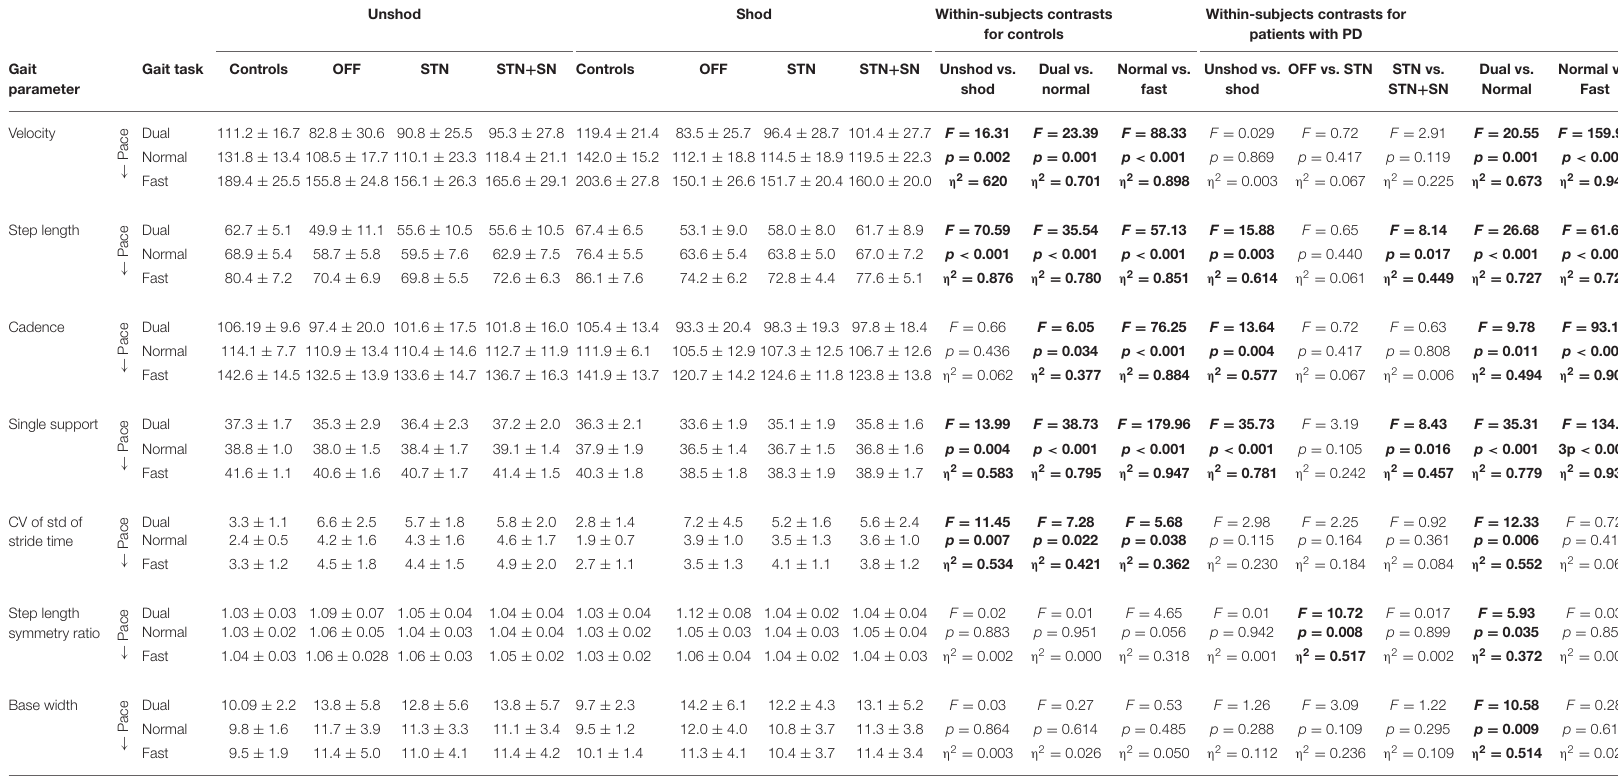
Comparison of gait parameters walking barefoot and with shoes during the three gait tasks under the three stimulation conditions. The stimulation conditions were as follows: OFF, DBS switched off; STN, conventional deep brain stimulation of the subthalamic nucleus (STN DBS); STN + SN, combined STN + SN DBS. Gait tasks were as follows: Dual, gait during the dual task; Normal, normal gait; Fast, fast gait. Values reported are mean ± SD calculated for both legs. The p-values < 0.05 are highlighted in